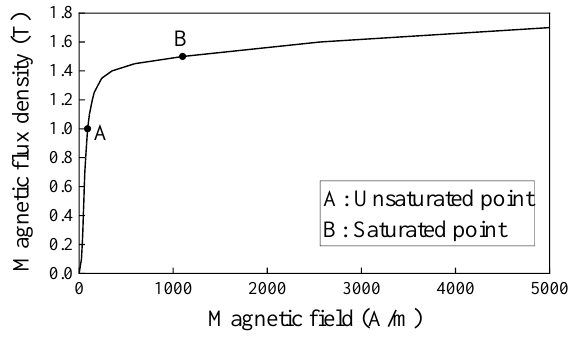
Figure 1. B–H curve of 35JNE230.